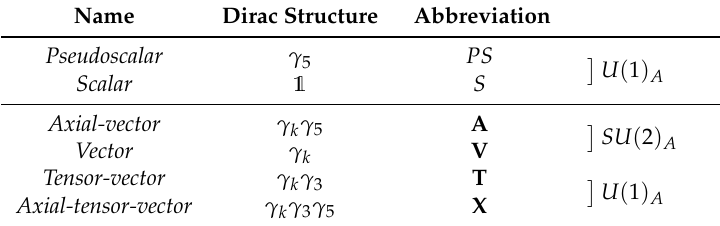
This classification assumes propagation in z -direction. The index k denotes the components 1,2,4, i.e., x , y , t .